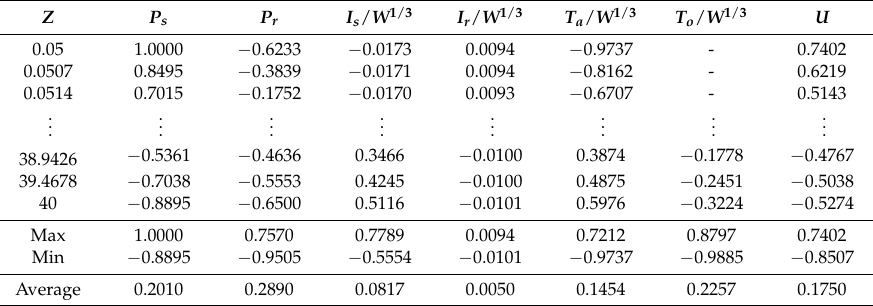
Table 5. Error of Modified Equation for Free-Air Burst (Unit: %).